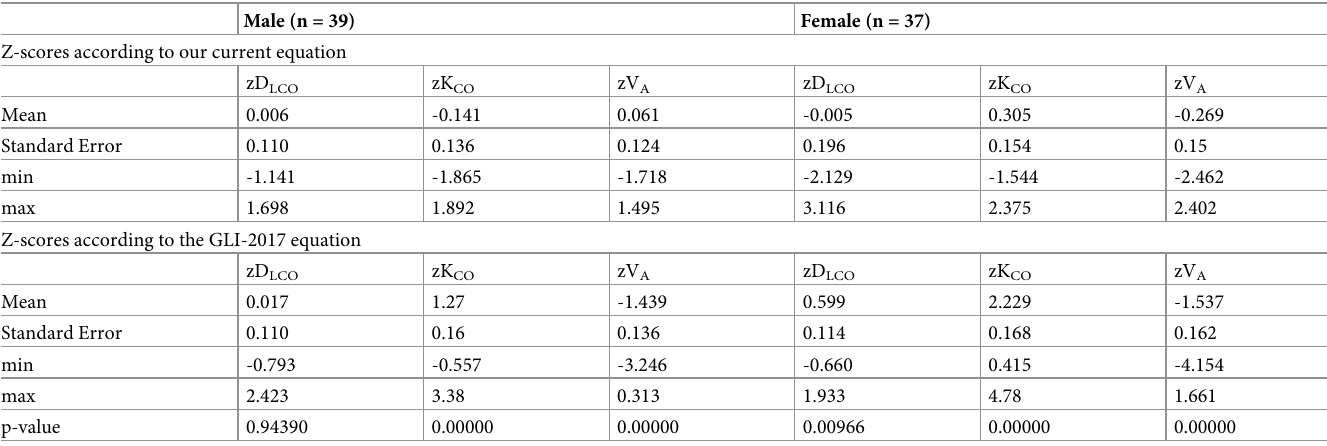
Table 3. Z-scores for D LCO , K CO and V A according to our current equation and the GLI-2017 equation for the Japanese